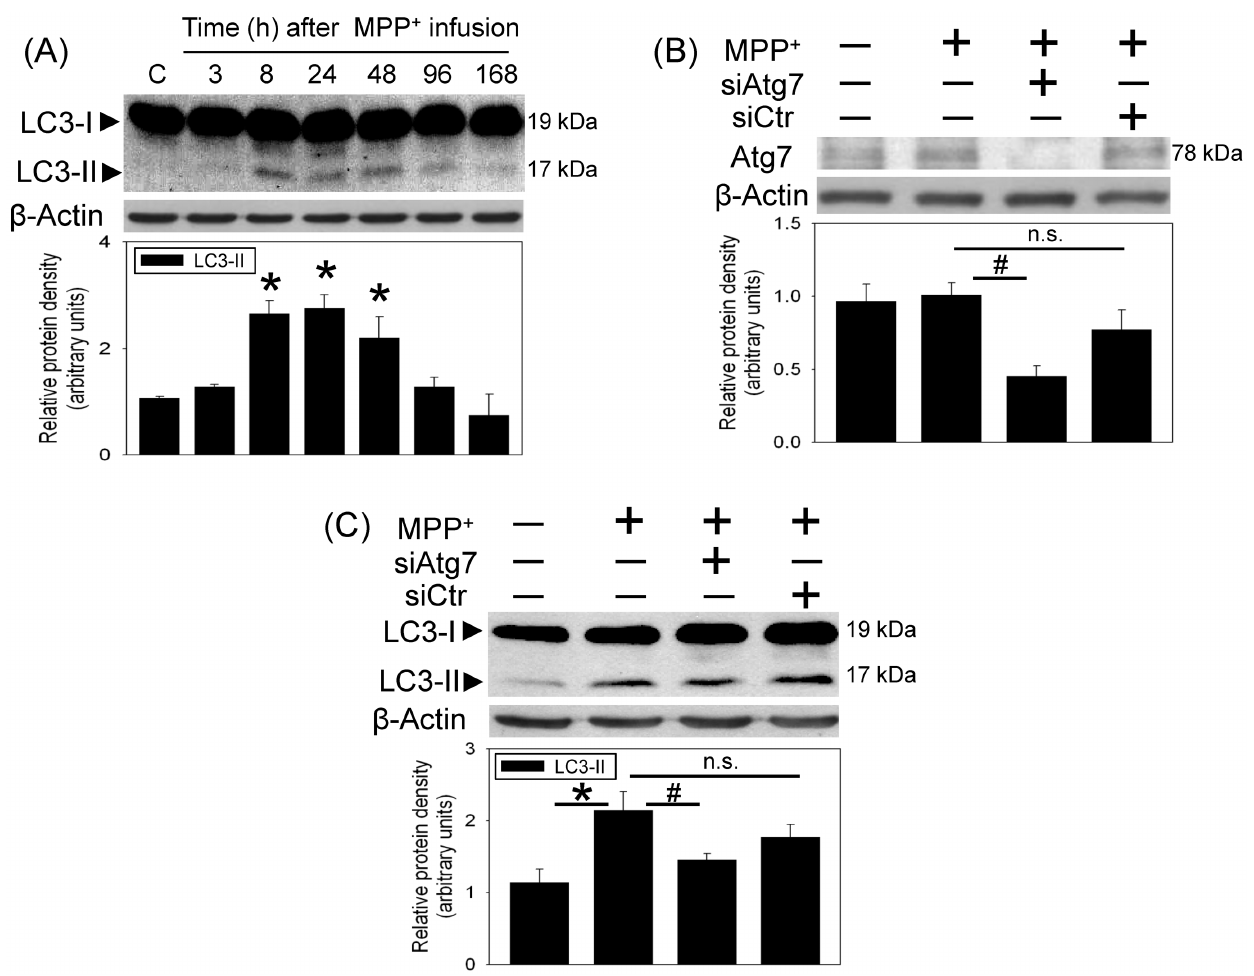
Figure 2. MPP + induced autophagy in the nigrostriatal dopaminergic system of rat brain. Intranigral infusion of MPP + (3 m g/ m l) was performed in the anesthetized rats. Rats were sacrificed at the indicated times. (A) Time-dependent effects of MPP + on LC3-II level in the substantia nigra (SN) were studied using Western blot assay. Graphs show statistical results from relative optical density of bands on the blots estimated by Image J software. Values are the mean 6 S.E.M. (n=3/group). *P , 0.05 in the MPP + -treated groups compared with the control groups by one-way analysis of variance (one-way ANOVA) and followed by the LSD test as post-hoc method. (B and C) Intranigral infusion of Atg7siRNA was performed 4 days prior to intranigral infusion of MPP + (3 m g/ m l) in chloral hydrate-anesthetized rats. Rats were sacrificed 30 h after intranigral infusion of MPP + . The levels of Atg7protein (B) and LC3-II (C) levels in SN were measured using Western blot assay. Each lane contained 25 m g protein for the experiments. Graphs show statistical results from relative optical density of bands on the blots estimated by Image J software. Values are the mean 6 S.E.M. (n=4/ group). * P , 0.05 in the MPP + -infused SN compared with the intact SN, # P , 0.05 in Atg7siRNA transfected and MPP + -infused SN compared with MPP + -infused SN, n.s. for not significant by Kruskal-Wallis test and followed by Mann-Whitney U test as post-hoc